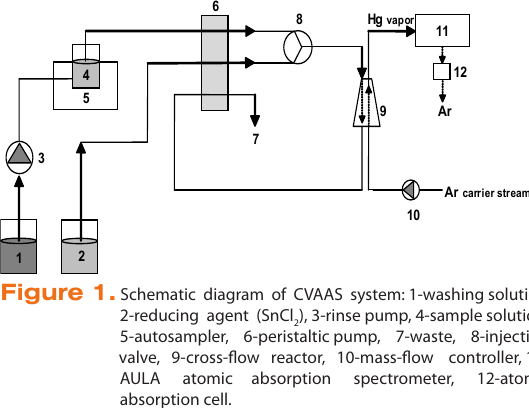
Figure 1. Schematic diagram of CVAAS system: 1-washing solution, 2-reducing agent (SnCl ), 3-rinse pump, 4-sample solution, 2 5-autosampler, 6-peristaltic pump, 7-waste, 8-injection valve, 9-cross-flow reactor, 10-mass-flow controller, 11- AULA atomic absorption spectrometer, 12-atomic absorption